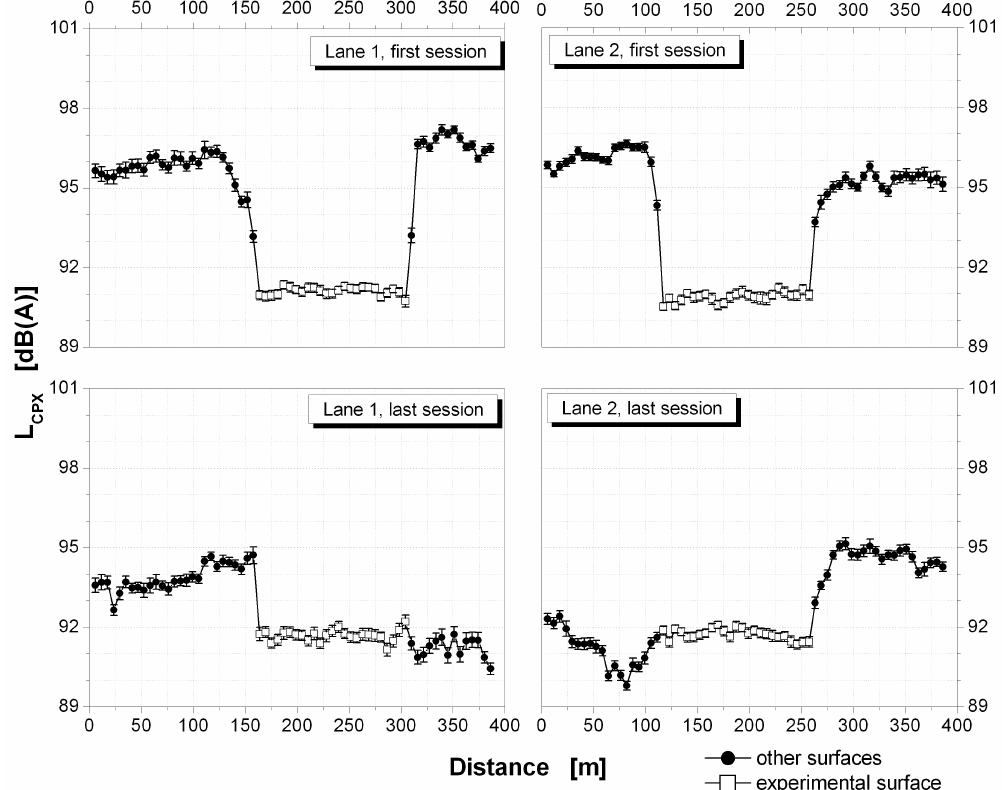
Figure 20. CPX data spatial distribution obtained during first session (upper figures) of measurements and during last one (lower figures) at Site 6. Lane 1 results are represented on the left plots while lane 2 ones are on the right plots. Experimental stretches data are marked with white squares.